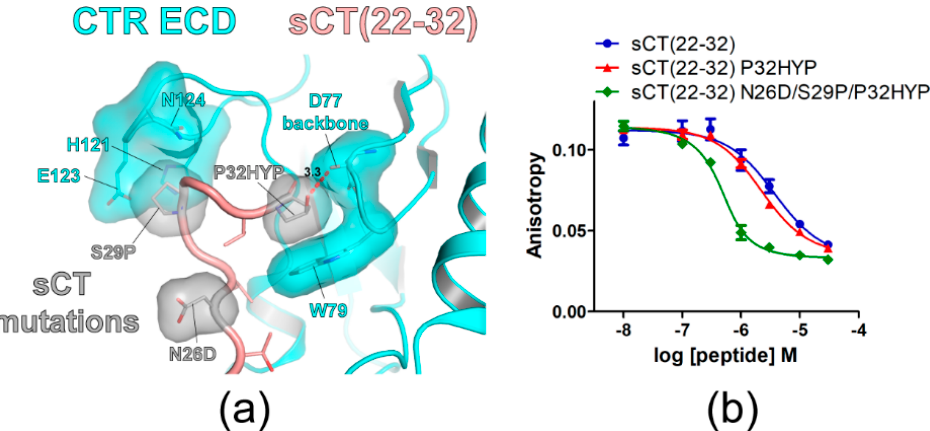
Figure 4. sCT P32 to hydroxyproline mutation increased sCT(22–32) affinity for CTR ECD. ( a ) The hypothetical structure of CTR ECD (PDB 6PFO, Mol A) with sCT(22–32) N26D/S29P/P32HYP mutations. CTR ECD D77, W79, H121, E123, and N124 and sCT N26D, S29P and P32HYP mutated residues were shown both with stick and surface representations. The distance between sCT HYP32 and the CTR ECD D77 main chain was shown as a dotted red line and was measured as 3.3 Å. ( b ) FP competition peptide binding assay with sCT(22–32) P32HYP and N26D/S29P/P32HYP mutations. FITC-sCT(22–32) was used as a peptide probe. Representative peptide-binding curves were shown from at least three independent experiments.